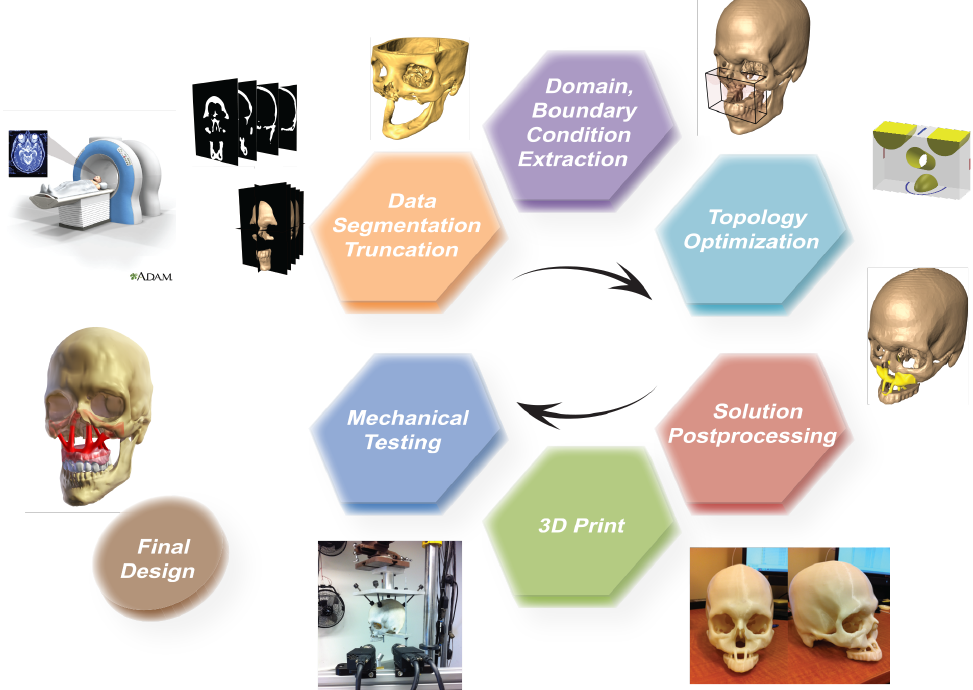
Figure 1. The workflow of using structural topology optimization for craniofacial bone